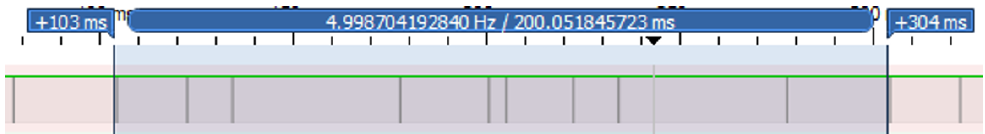
Figure 17. CAN bus occupancy in a full US ring processing cycle of 200 ms.